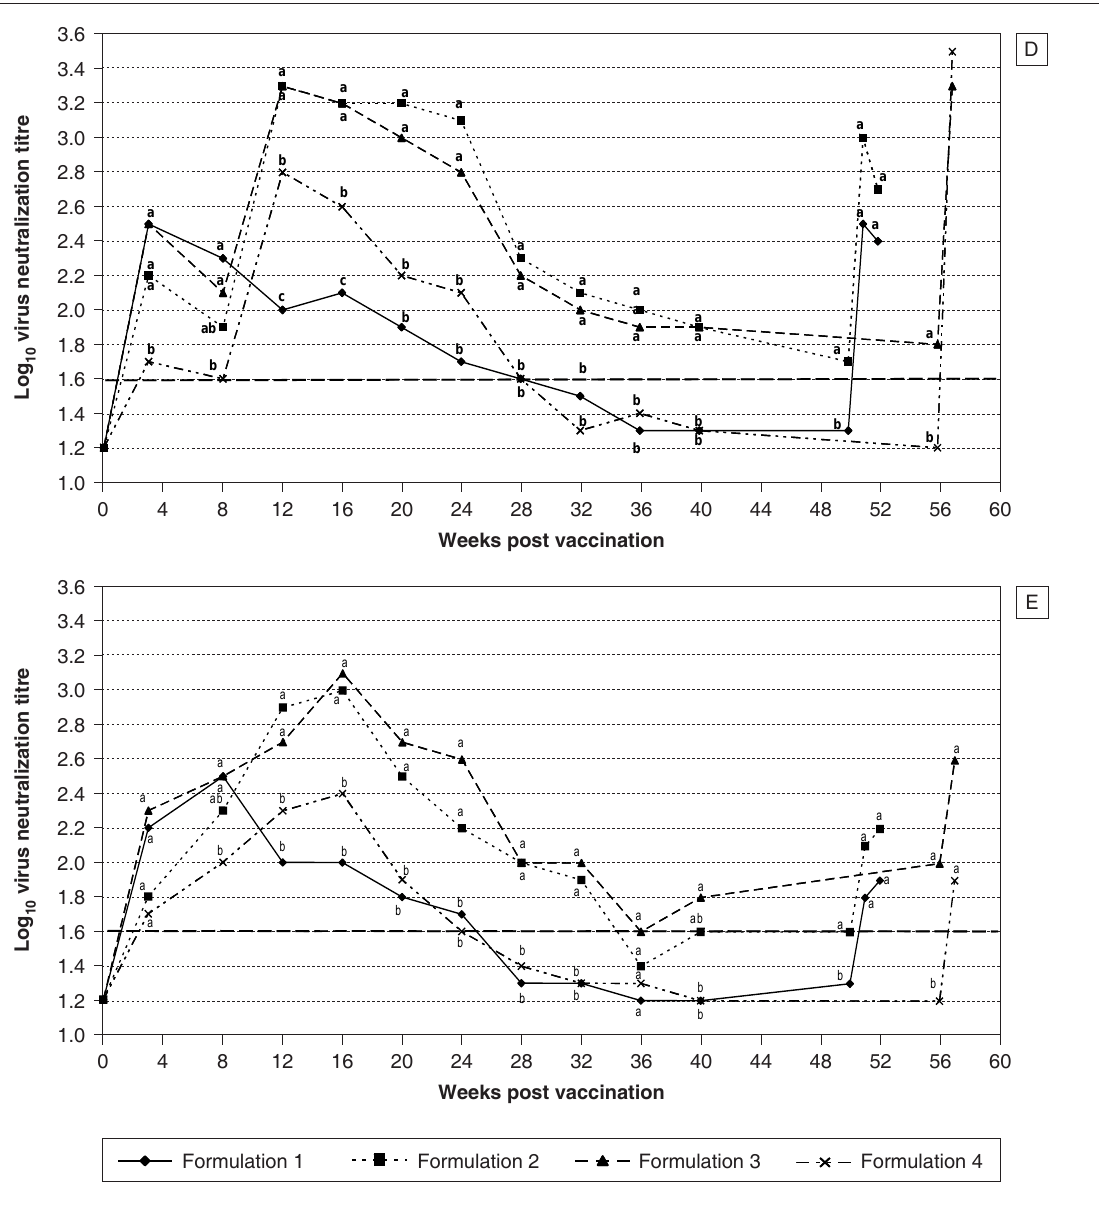
FIG. 1 Evaluation of FMD vaccine formulations 1–4 Cattle vaccinated with formulation 1 received a booster at 4 weeks, while all other groups received boosters at 8 weeks. Neutralizing titres were determined using VNT and titres ≥ 1/45 or ≥ 1.6log deemed positive (the cut-off is shown). The neutralizing titres elicited by the different SAT antigens present in the different vaccine formulations for weeks 4–40 were analysed using a one-sided ANOVA to test for differences in immune responses between the different vaccine formulations. The data were acceptably normal and variances were homogenous at the 1 % confidence level. The neutralizing titres determined at weeks 50–59 were analysed differently via analysis of an unbalanced design using Genstat regression to test for differences in immune responses between the different vaccine formula- tions. The data were acceptably normal with heterogeneous treatment variances. The treatment means were separated using Fishers’ protected t-test least significant difference (LSD) at the 1 % level of sig- nificance (Snedecor & Cochran 1980). The points on the graph represent the average titres of the six cattle in each group per collection date. Titres to SAT 1A (A), SAT 1B (B), SAT 2A (C) and SAT 2B (D) and SAT 3 (E) are indicated in separate